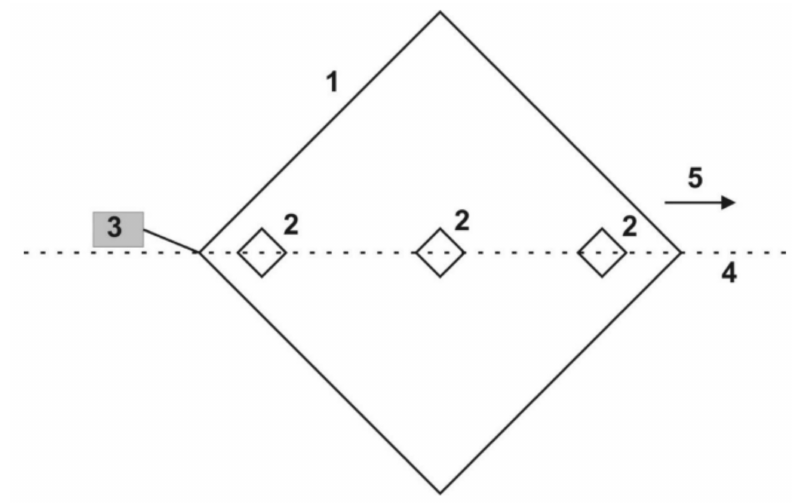
Figure 5. Scheme of measurements by the TEM method along the profile. 1—generator loop, 2— induction sensors with meters, 3—current switch and laptop, 4—profile, 5—direction of movement along the profile, dotted line—profile line.